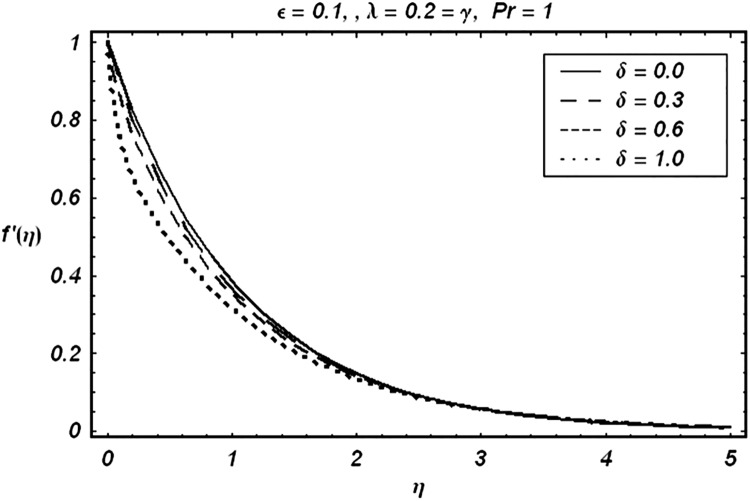
Variation of δ on f′.